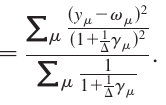
ffiffiffiffi p ¼ 10 (cid:5) 4 . The EM-BP ( L ¼ 1 ) and s-BP strategy ( L ¼ 4 , J (cid:3)